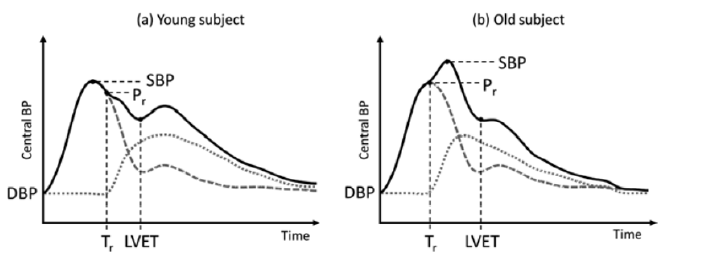
Figure 8. Visualization of difference in pressure curve morphologies for young and old subjects. Reprinted with permission from [5]. © 2019, Springer Nature Switzerland